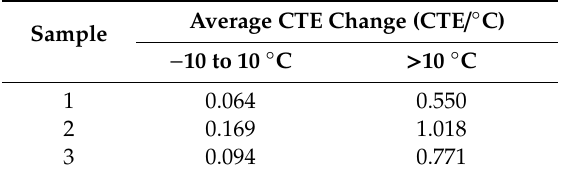
Figure 13. Comparison of CTE measurements between samples 1, 2 and 3. Curve fit for sample 1: α = 0.005052 T 2 + 0.07656 T + 1.349, curve fit for sample 2: α = 0.00464 T 2 + 0.1428 T + 3.408 and curve fit for sample 3: α = 0.002033 T 2 + 0.09219 T + 2.348. Table 3. Average change in CTE with increasing temperature.